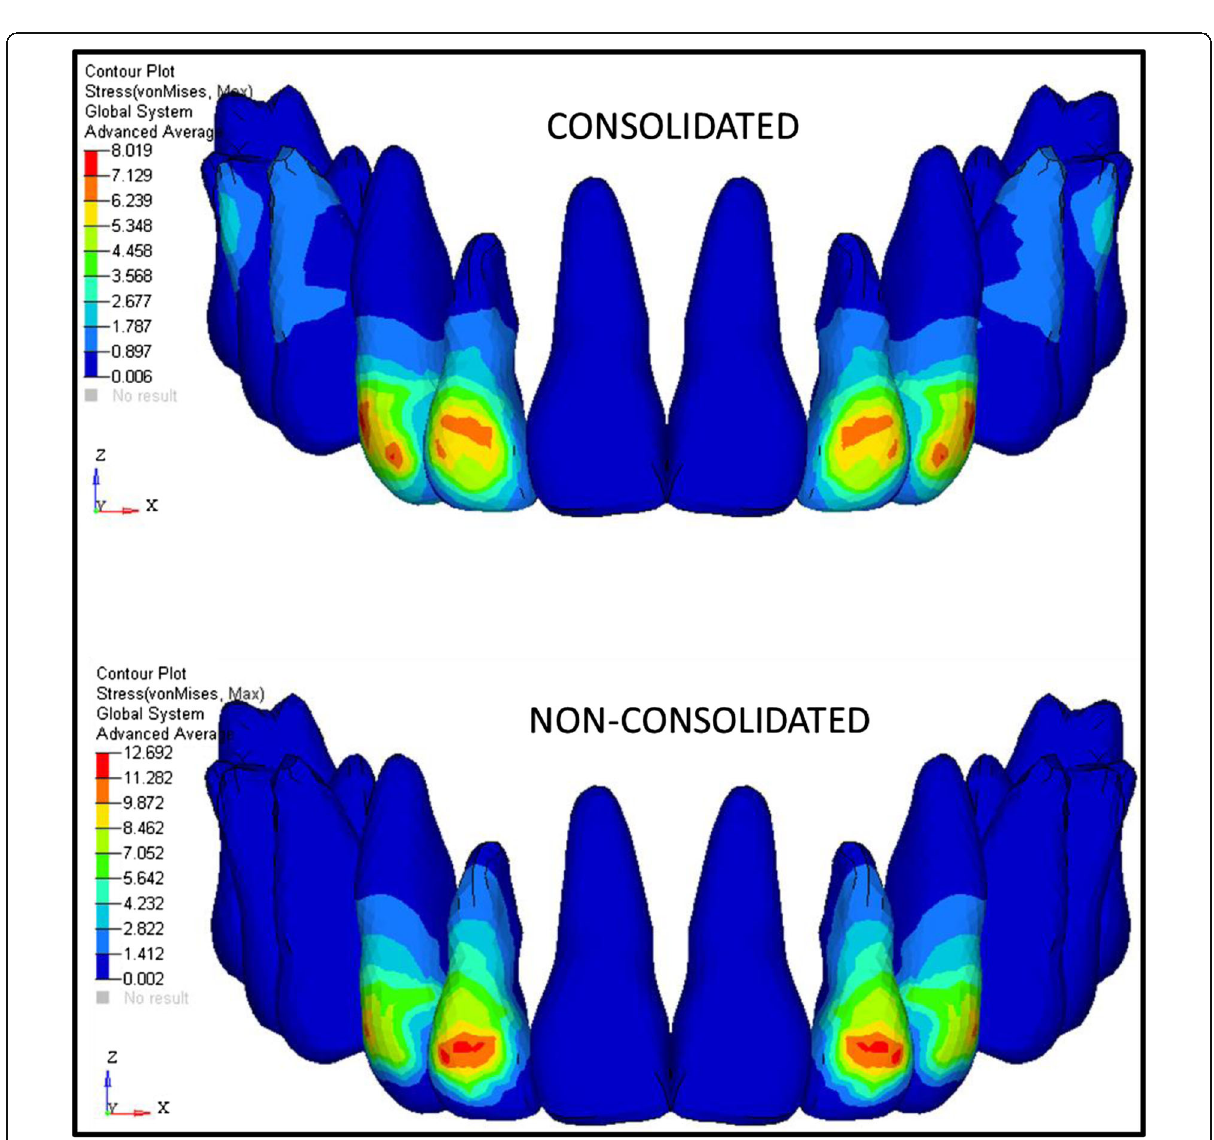
Fig. 8 Stress distribution patterns on the